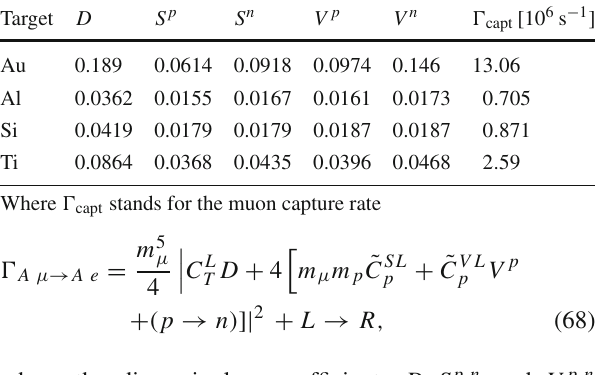
The Feynman diagram for A μ → A e conversion is